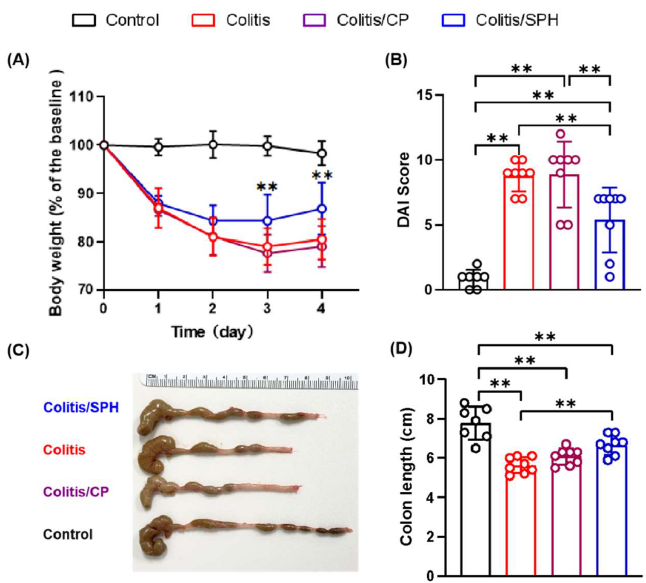
Figure 2. Protective role of SPH in TNBS-induced colitis model. ( A ) Longitudinal body weight change of the baseline (%). Note that except for the Control group (n = 7), the body weights in the other three groups (all n = 8) on days 1–4 were significantly lower than those on day 0 ( p < 0.01), and the changes in body weight of the baseline were higher than that in the Control group at each time point ( p < 0.01). **: SPH treatment attenuated weight loss on day 3 and 4 compared to Colitis and Colitis/CP groups ( p < 0.01). ( B ) Disease activity index (DAI) scores. ( C ) Representative macroscopic images of colon changes. ( D ) Comparison of colon length. Data are presented as mean ± SD and analyzed by one-way ANOVA ( B , D ) or two-way ANOVA test ( A ). **: p < 0.01.